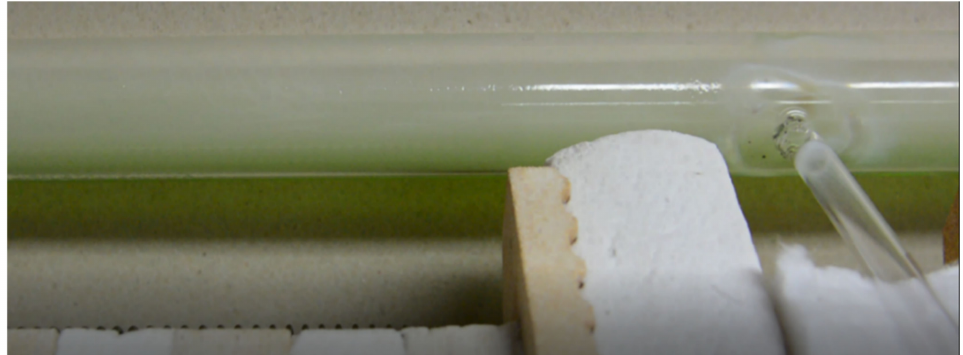
Figure 13. Nitrogen flow = 15 L/min without detecting H 2 leakage back into the evaporation